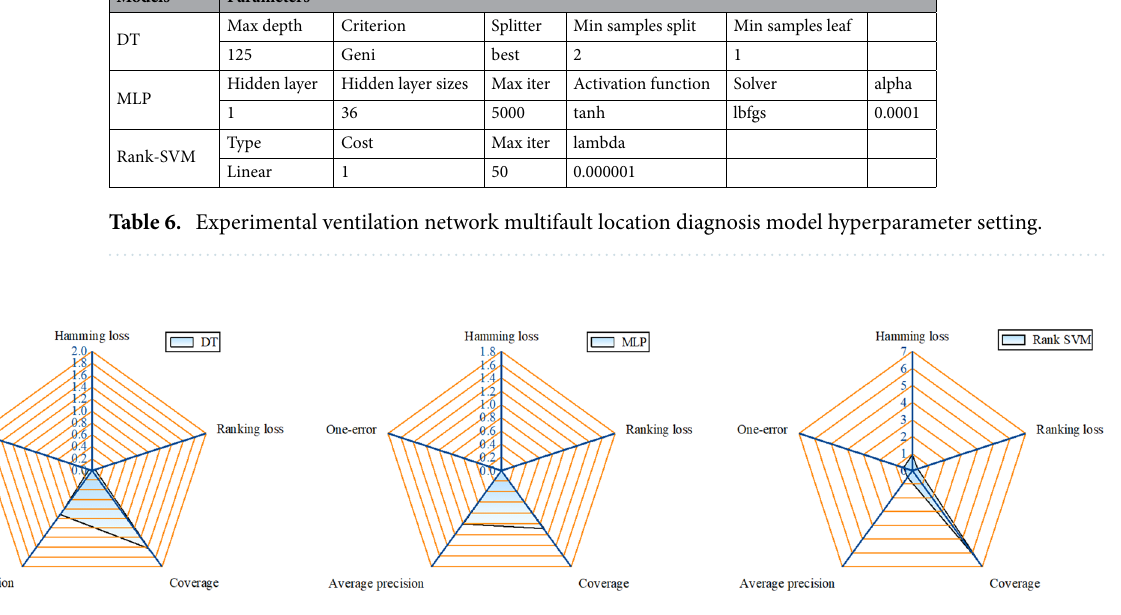
Figure 8. Cross-validation results of the experimental system for RVMFL